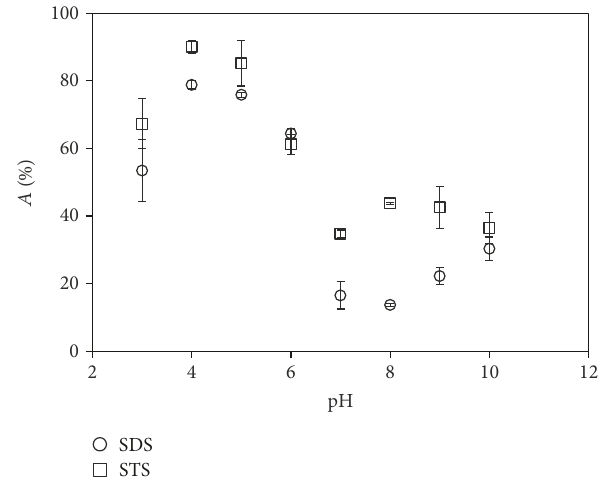
Figure 3: E ff ect of pH on the adsorption e ffi ciency of SDS and STS O . Error bars show standard deviations of three onto Al 2 3